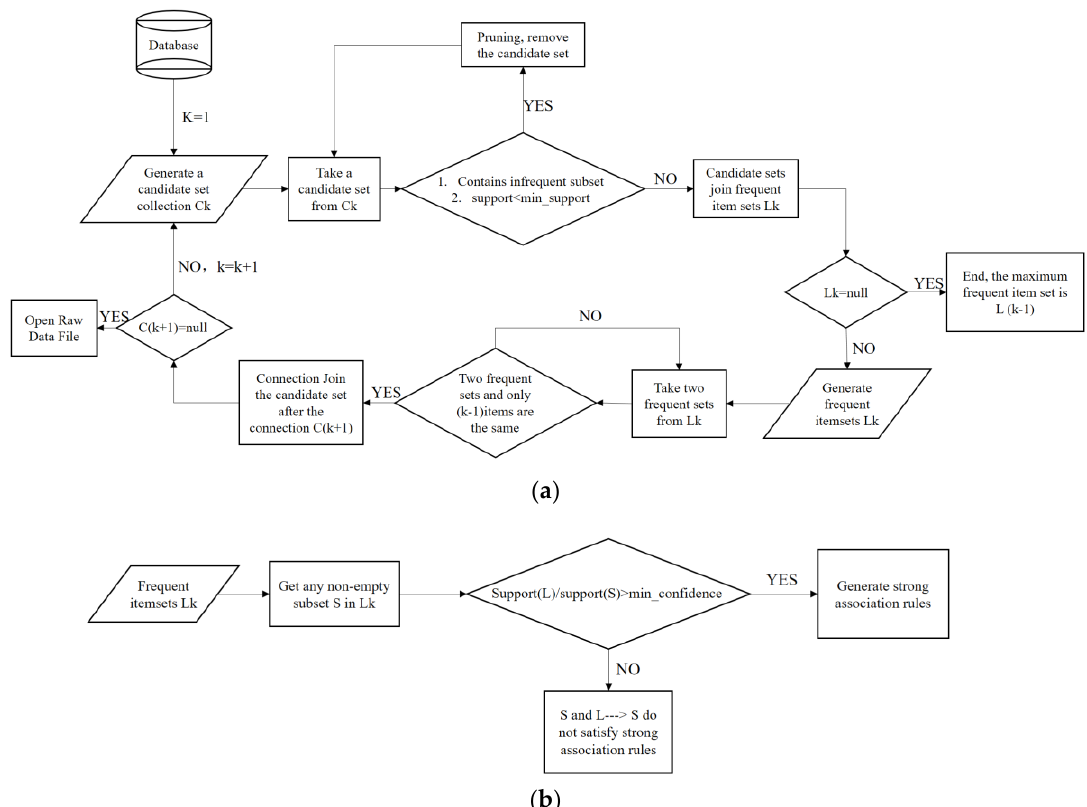
Figure 5. ( a ) Apriori Algorithm Step 1: Generate Frequent Item set 𝐿 𝑘 . ( b ) Apriori Algorithm Step 2: Find Strong Association Rules.